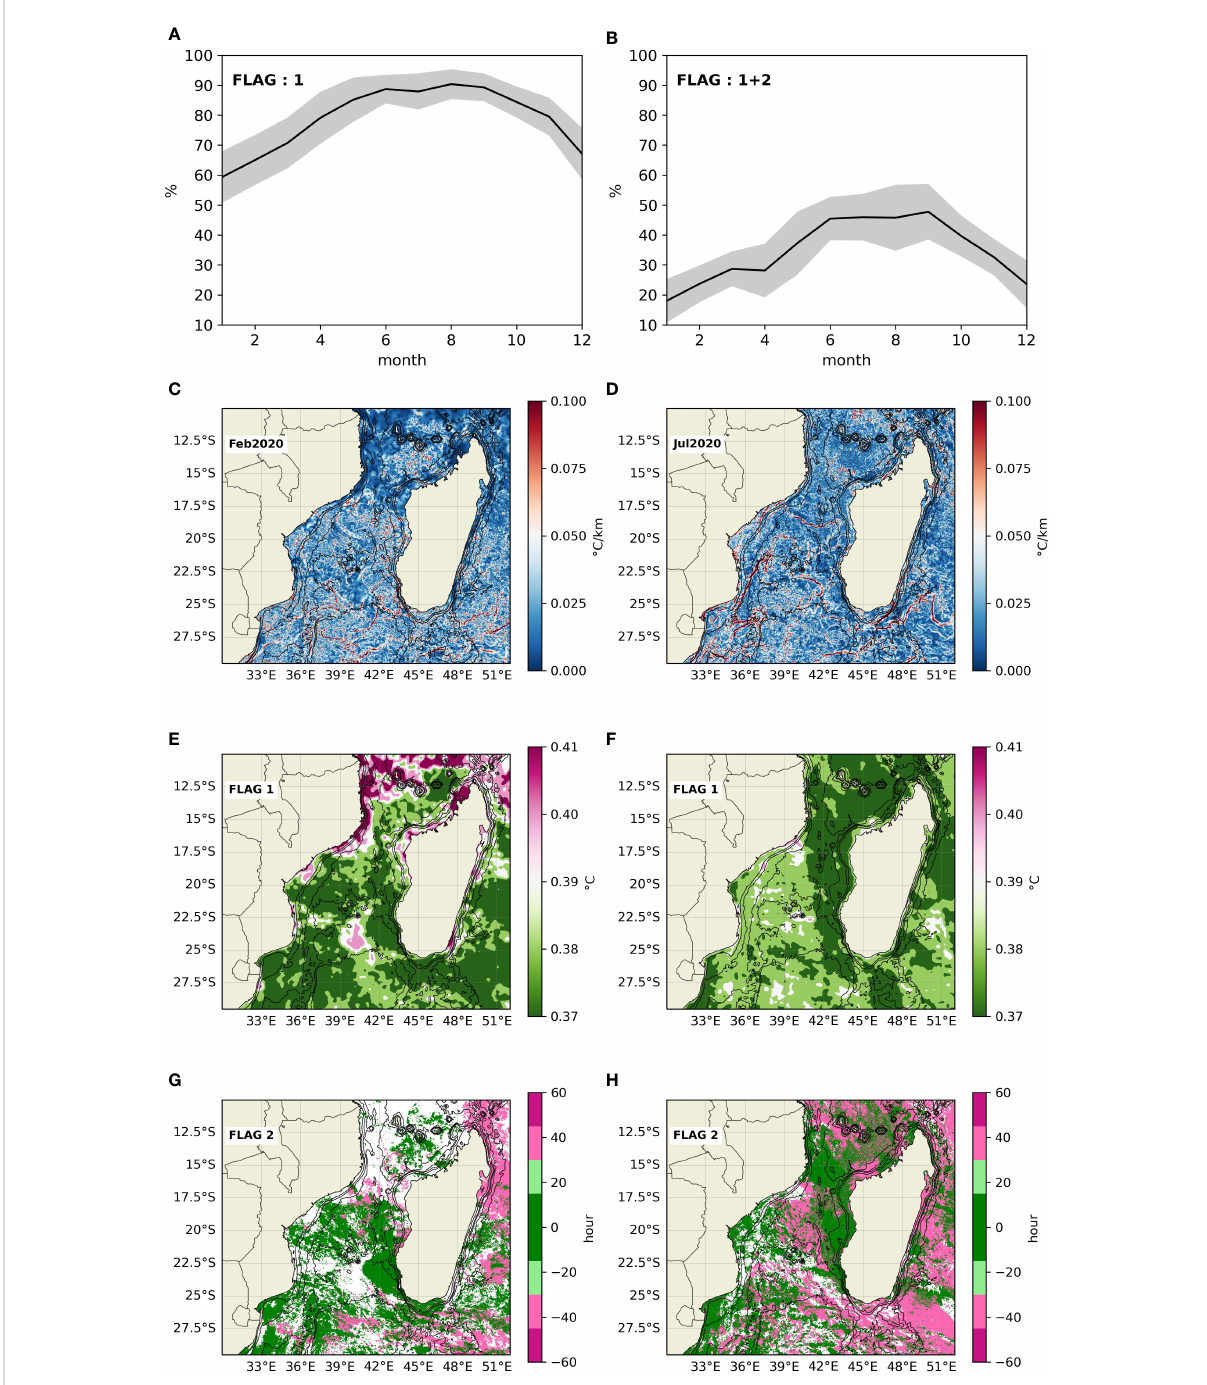
FIGURE 8 The fi rst row represents the climatology of the percentage of pixel deemed of a suf fi cient quality for frontal analysis based on: fl ag 1 for 2003- 2020 (A) ; or fl ag 1 and fl ag 2 for 2017-2020 (B) . The grey shaded area is the standard deviation from the climatology mean. The 2nd row shows temperature front intensity snapshots for February (C) and July (D) 1st, 2020. The 3rd and 4th row correspond to the same dates as the 1st row and show the corresponding fl ag values: fl ag 1 (E, F) and fl ag2 (G, H)